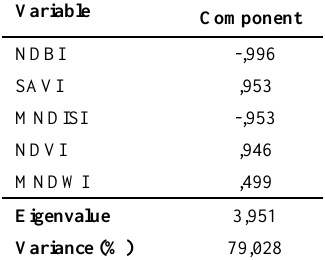
Table 4. Rotated component